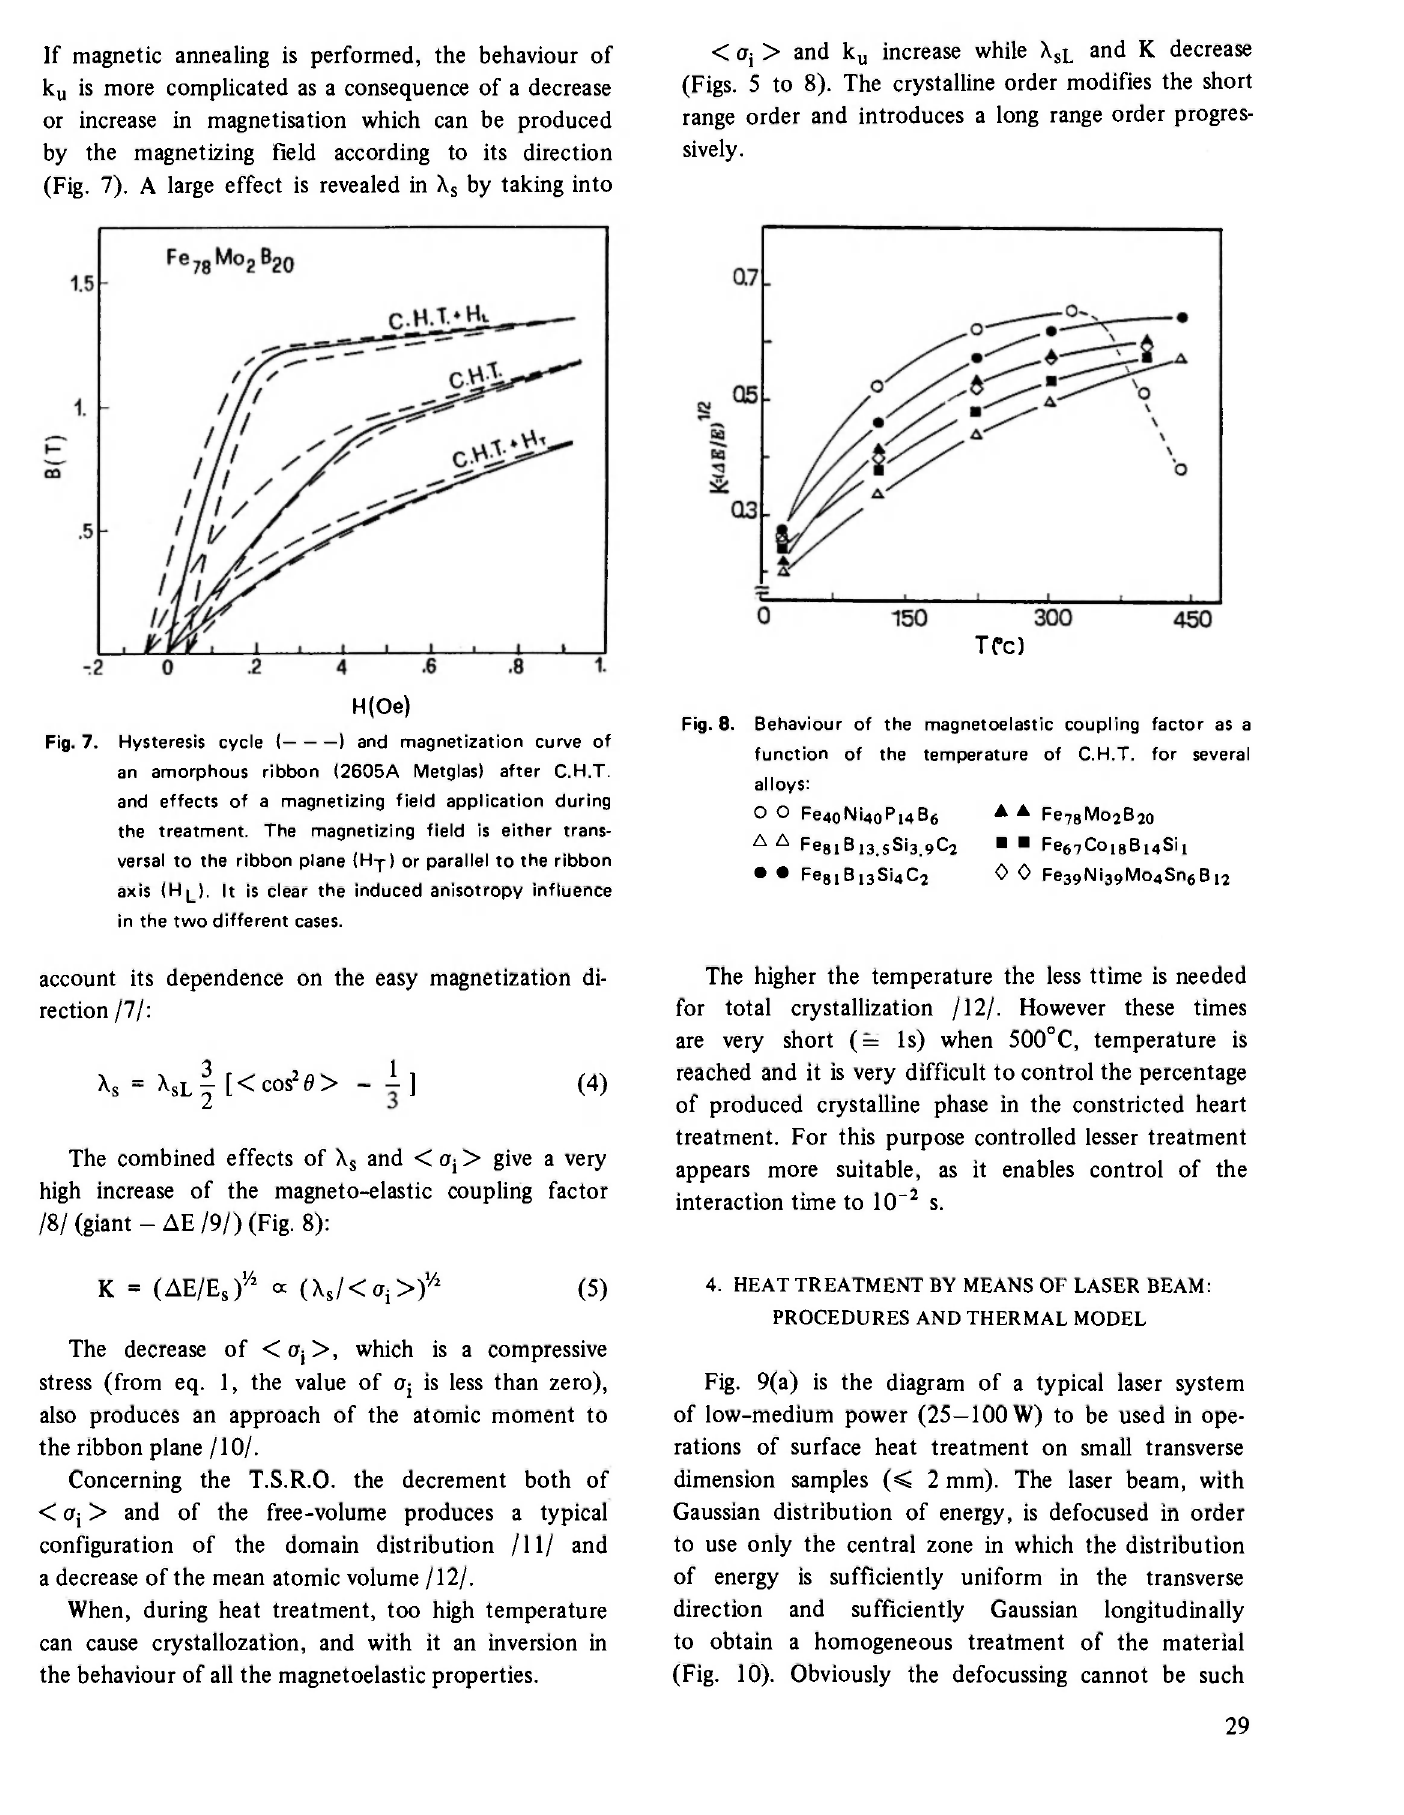
Fig. 8. Behaviour of the magnetoelastic coupling factor as a function of the temperature of C.H.T. for